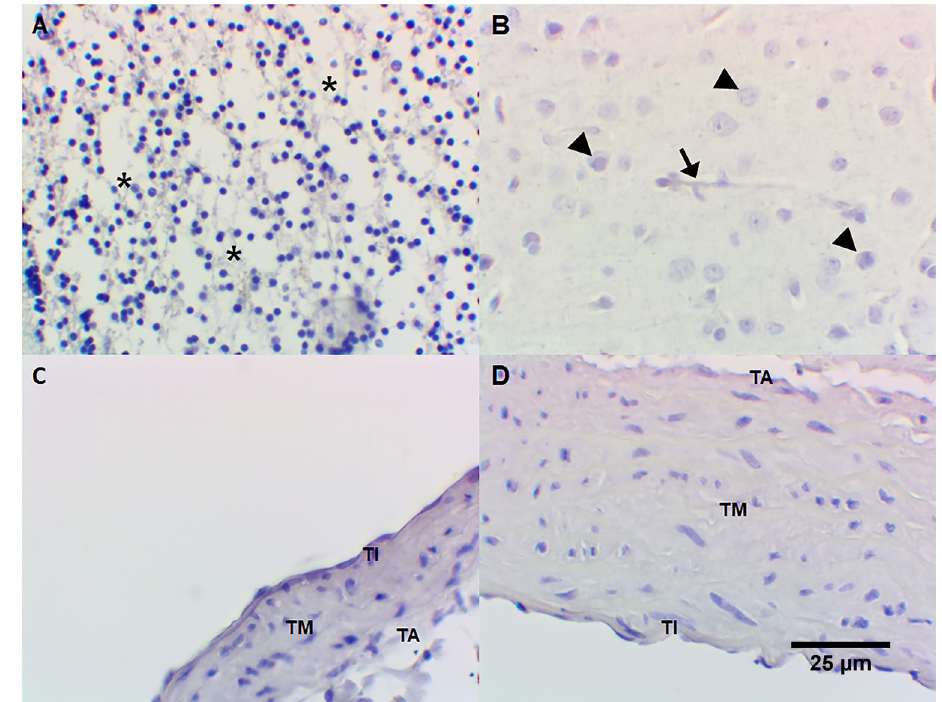
Figure 10. Negative controls (omission of anti-S-100 and anti-calretinin). A , Human cerebellum; B , Callithrix spp. brain; C , pulmonary artery of Callithrix ; D , aorta of Callithrix . TI: tunica intima; TM: tunica media; TA: tunica adventitia. These images show absence of immunostaining in neuropil (*), glial nuclei (arrowhead), and neuron axons (black arrow). Immunoperoxidase, 400 (cid:3) (original magni fi cation), scale bar 25 m m.